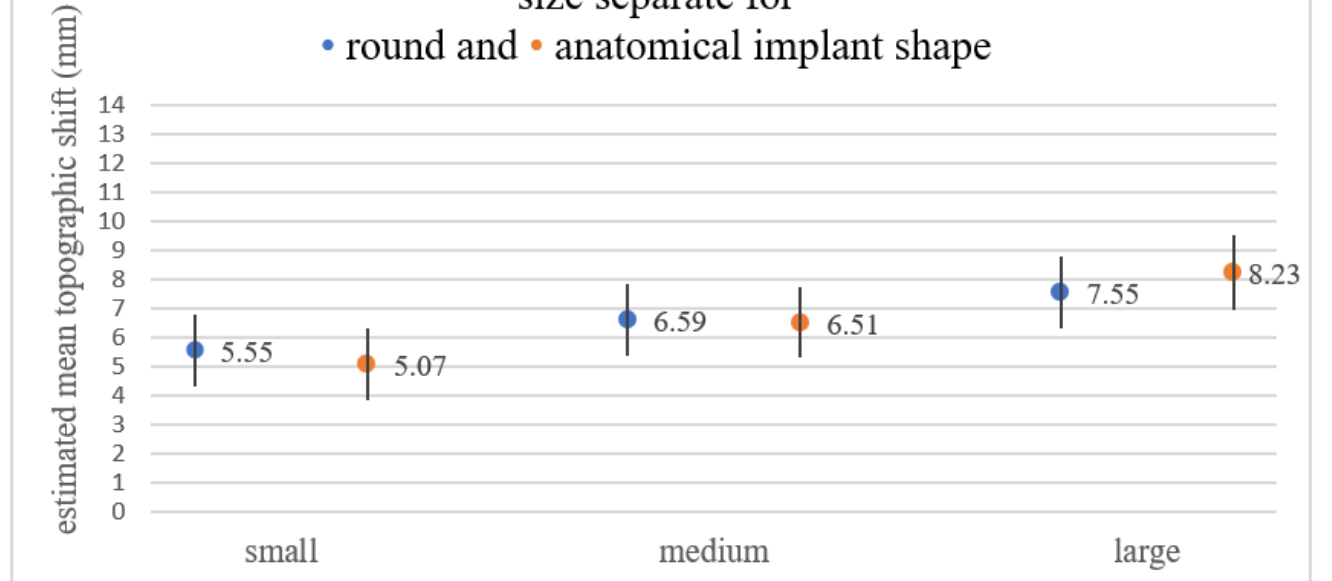
Figure 3. Estimated mean TS for each implant size (small/medium/large) in round and anatomical shaped implants. No significant difference was observed between round and anatomical shape in same-sized implants. However, in large implants, a bigger difference between implant shapes was observed (round: 7.55; anatomical: 8.23) compared to the medium and small sizes.